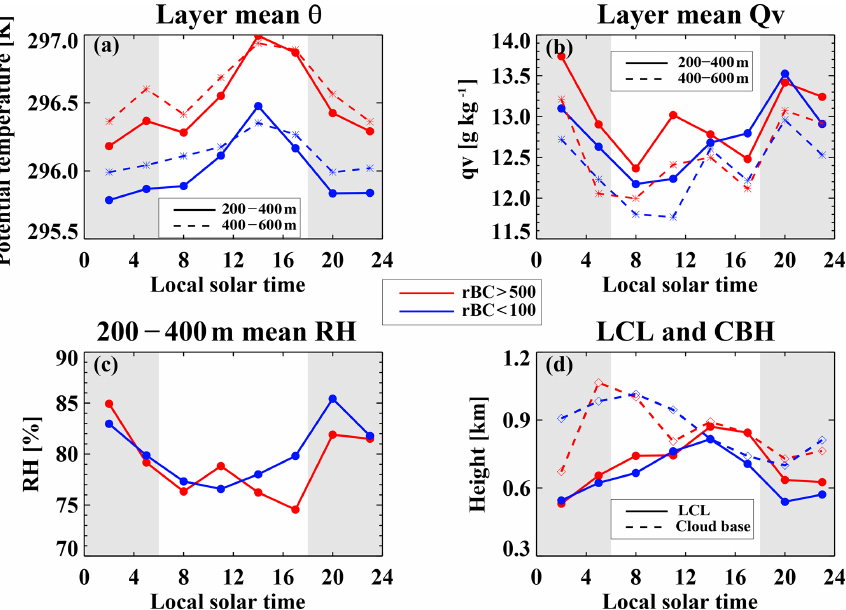
Figure 15. Diurnal cycle in the 3-hourly radiosonde-derived 200–400m (solid) and 400–600m (dashed) layer-averaged (a) potential tem- perature ( θ ), (b) water vapor mixing ratio ( Q v ), and (c) relative humidity (RH). (d) Radiosonde-derived lifting condensation levels (LCLs) and the 10th percentile of the lowest ceilometer-derived cloud base. All are composited by days with “more” (red) and “less”